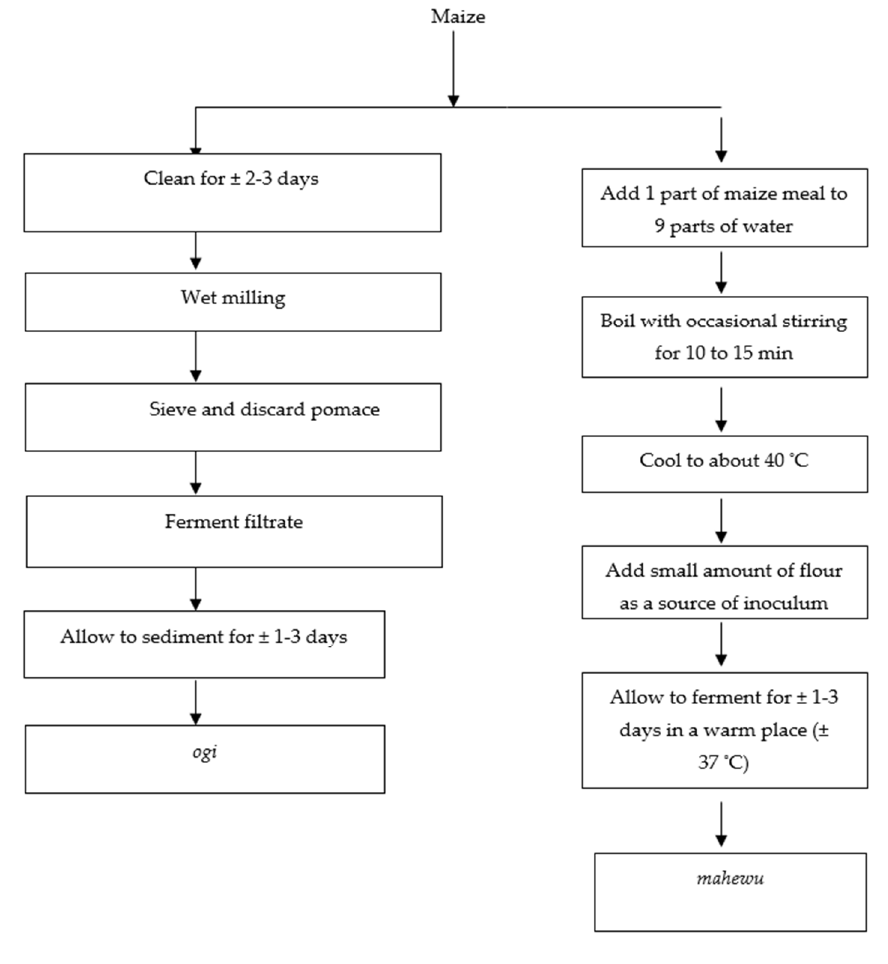
Figure 1. Flow diagram for the production of home-made mahewu and ogi